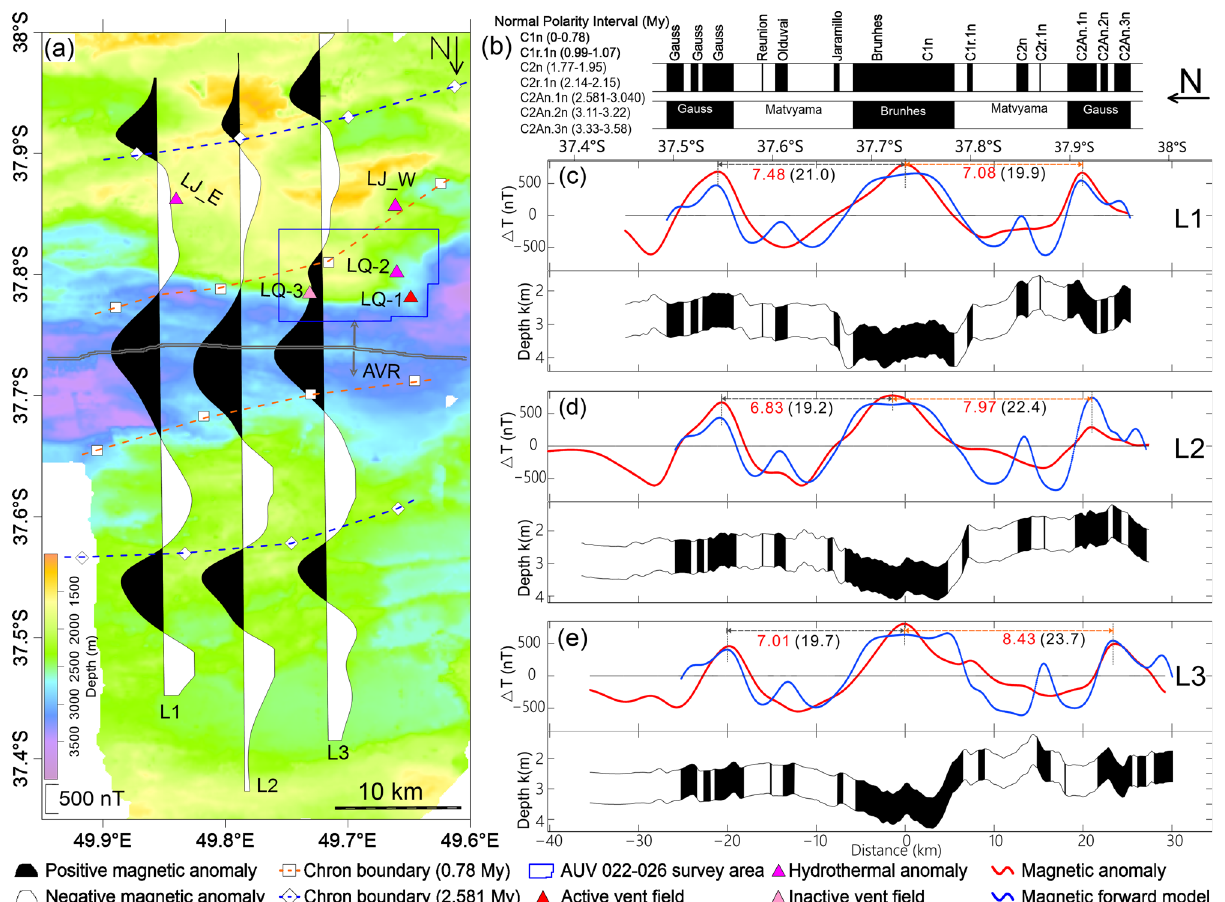
Fig. 2 The regional magnetic polarity structure of the Dragon Horn ridge segment as documented by sea-surface magnetic survey pro fi les. a Magnetic anomaly lineations. The boundaries of Brunhes (0.78 Myr) and Matuyama (2.581 Myr) obtained by ref. 19 are marked by pink and blue dashes respectively. b Geomagnetic polarity timescale 36 . c – e are comparisons between observed anomaly (red) and magnetic forward modeling results (blue) assuming a constant thickness source layer with 1 km. Where the fi gures in ( c – e ) noted by red color are half-spreading rates (in km Myr − 1 ) from the middle C2An.1n Chron to present-day and black numbers are the corresponding distances (in